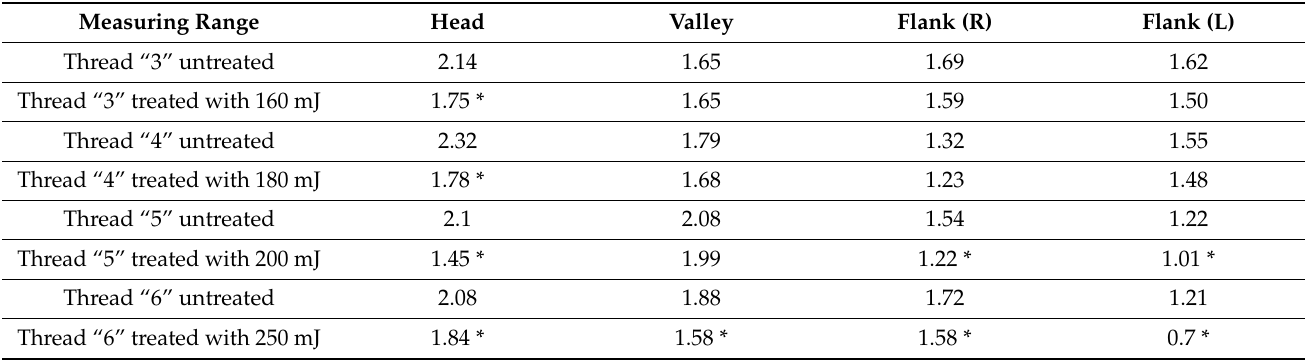
Table 2. Illustration of the treated and untreated implant surfaces of the Roxolid ® . Shown are the implant thread areas “3” to “6” where a change in roughness (*) was measured due to treatment with an Er:YAG laser. The values were given in µ m. No changes could be observed in implant thread areas “1” and “2” at 120 and 140 mJ,